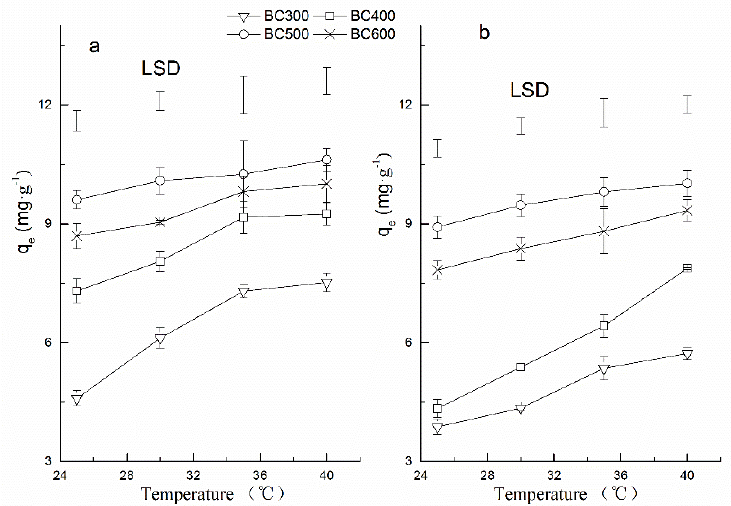
Figure 10. Effect of temperature on the sorption of Cu(II) ( a ) and Zn(II) ( b ) by BCs produced at different temperatures (initial Cu(II) concentration 64 mg L −1 , initial Zn(II) concentration 65 mg L −1 ; BC dosage 5 g·L −1 ; initial solution pH 5.0; contact time 1440 min). Error bars represent standard error ( n = 3). LSD is the least significant difference at p < 0.05 under the same reaction temperature.